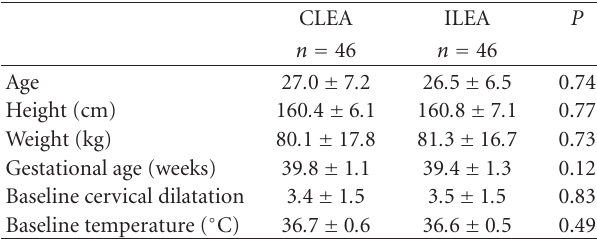
Table 1: Demographic data.